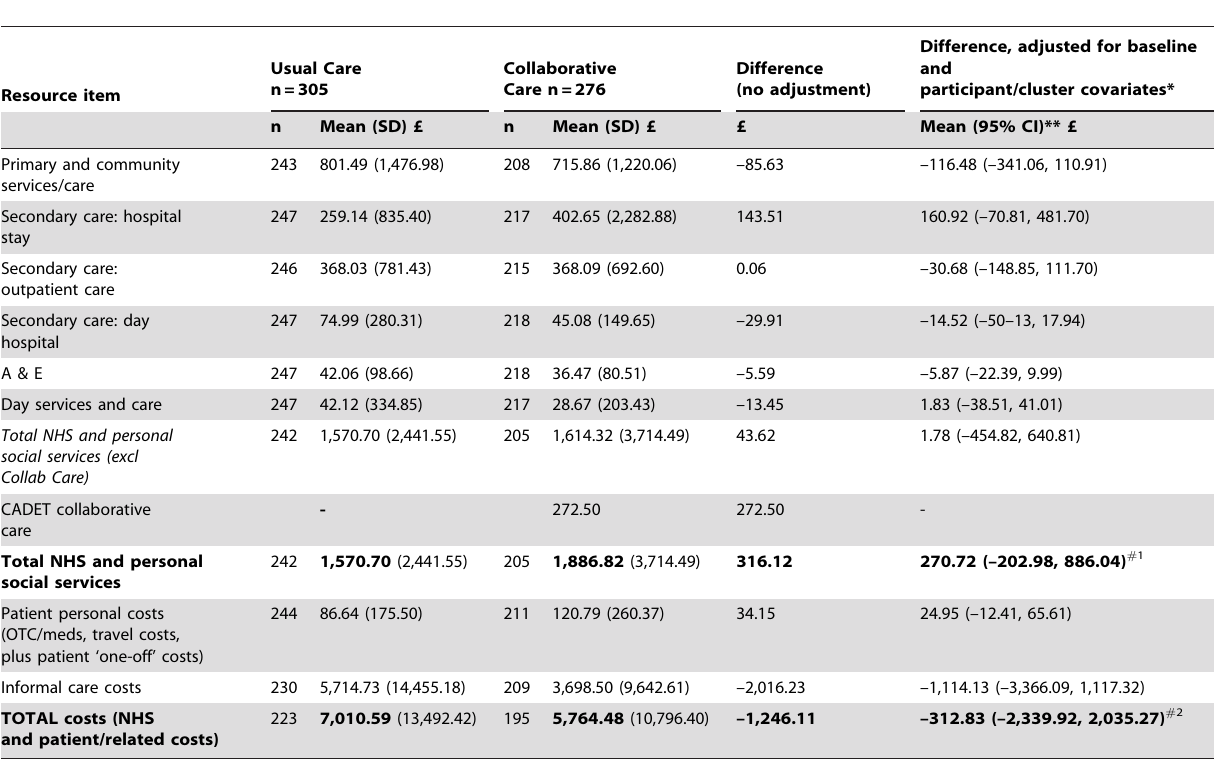
Table 4. Estimated costs, and cost differences (adjusted, unadjusted), over 12-month follow-up, by group.